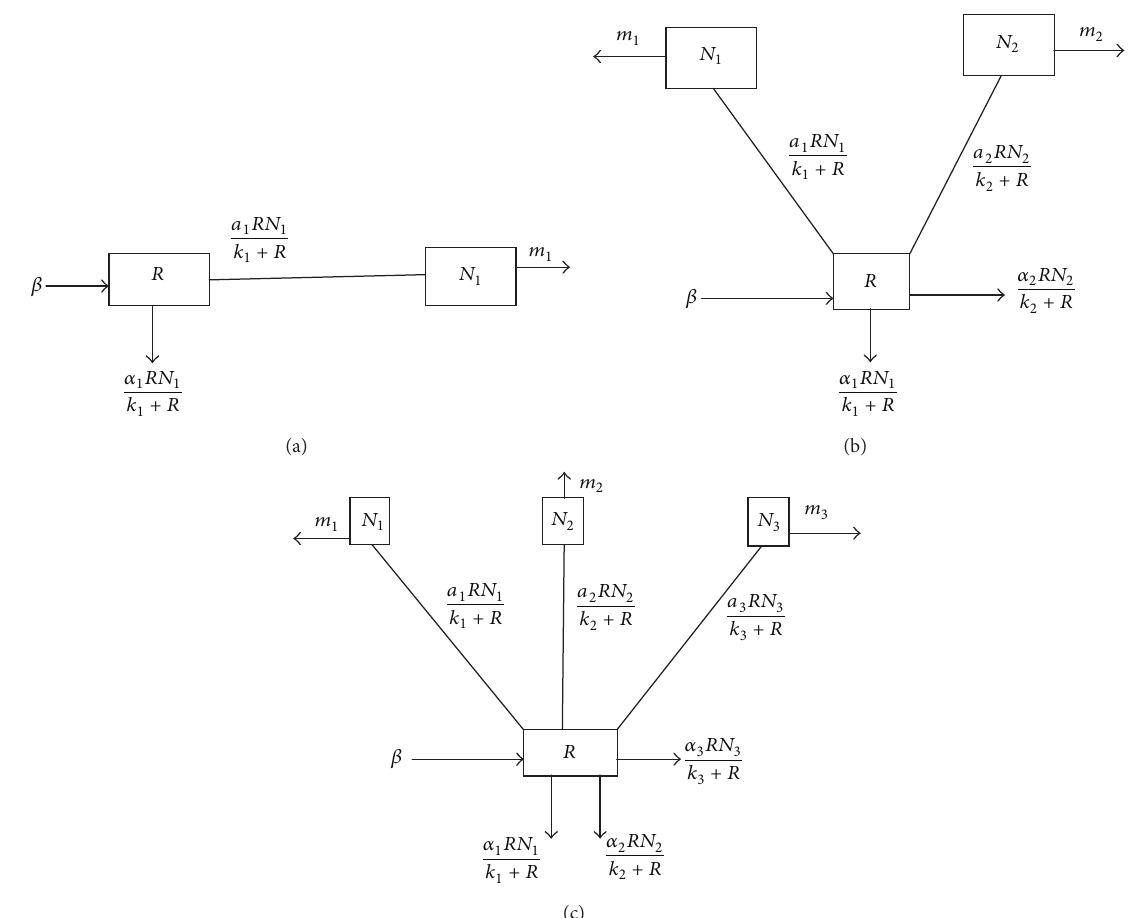
Figure 1: Flow charts summarizing the conceptual framework of the formulated models; the boxes represent state variables, which describe the state or condition of the system components. The arrows illustrate relationships among state variables as the movement of ecological interactions; (a) shows one species and one resource interactions, (b) represents two species competing for one resource, and (c) illustrates three species competing for one